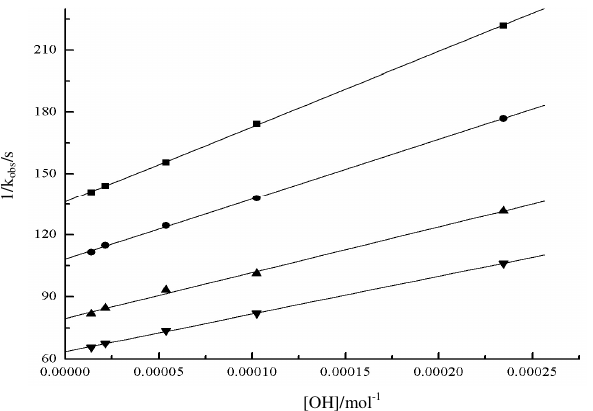
Figure 3. Plots of 1/ k versus [OH - ] at different temperatures (r ≥ 0.998) [Fe(VI)] = obs